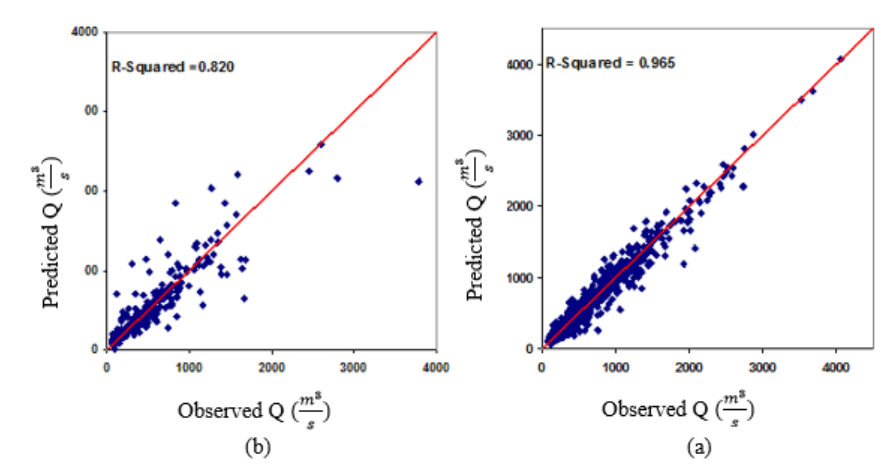
Fig. 11. Observed discharge versus predicted discharge for forecasting 𝑄(𝑡 + 1) : a) training data, b) testing